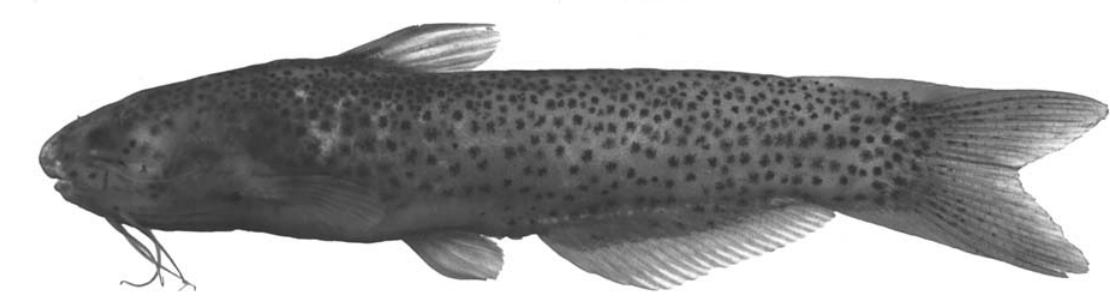
Fig. 5. Cetopsidium morenoi, INHS 34506, 20.5 mm SL; Venezuela, Guarico, río San Bartolo (8 o 03’N, 66 o 42’W).